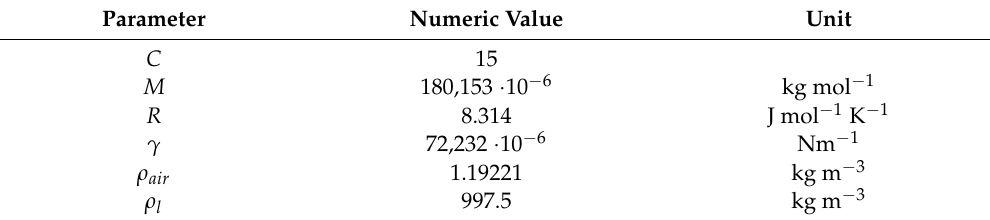
Table 1. Material parameters and properties used for free liquid water and water vapour at 296.15 K and 101,325